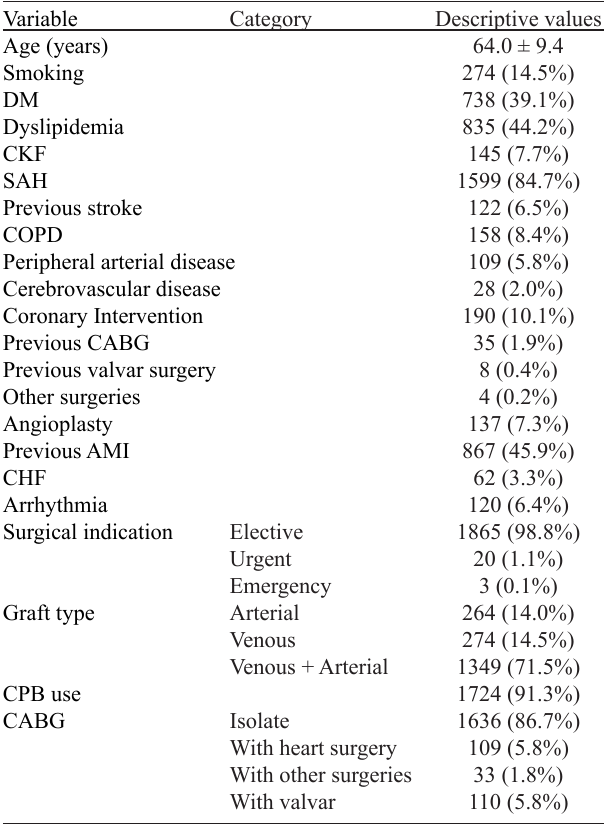
Table 1. Demographic values and characteristic description of transfused